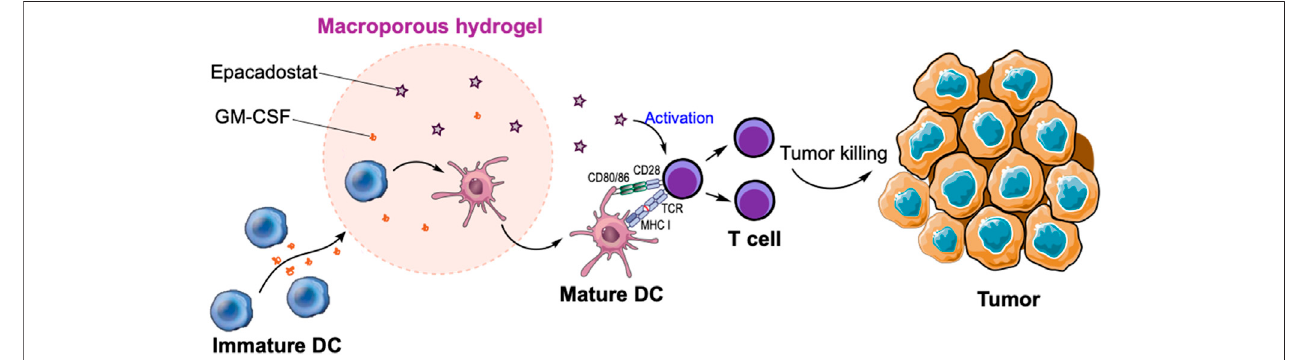
FIGURE1| Schematicillustrationof insitu recruitmentofDCsandactivationofTcells via macroporoushydrogelsloadedwithGM-CSFandepacadostat.GM-CSF can recruit massive DCs while epacadostat can activate CD8 + T cells, resulting in the improved killing of tumor cells.